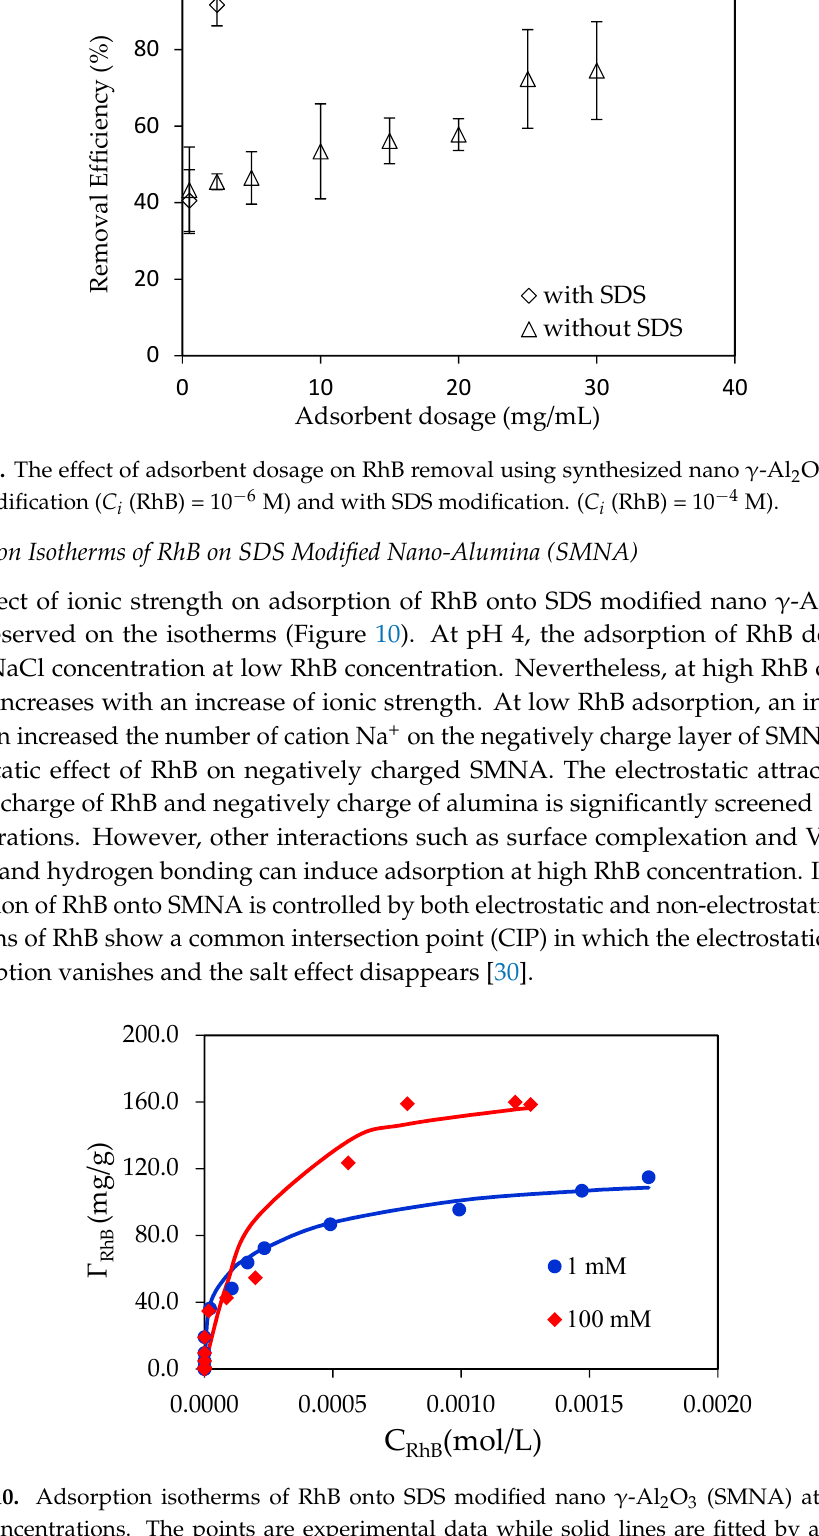
Figure 9. The effect of adsorbent dosage on RhB removal using synthesized nano γ -Al 2 O 3 without SDS modification ( C i ( RhB) = 10 − 6 M) and with SDS modification. ( C i ( RhB) = 10 − 4 M).